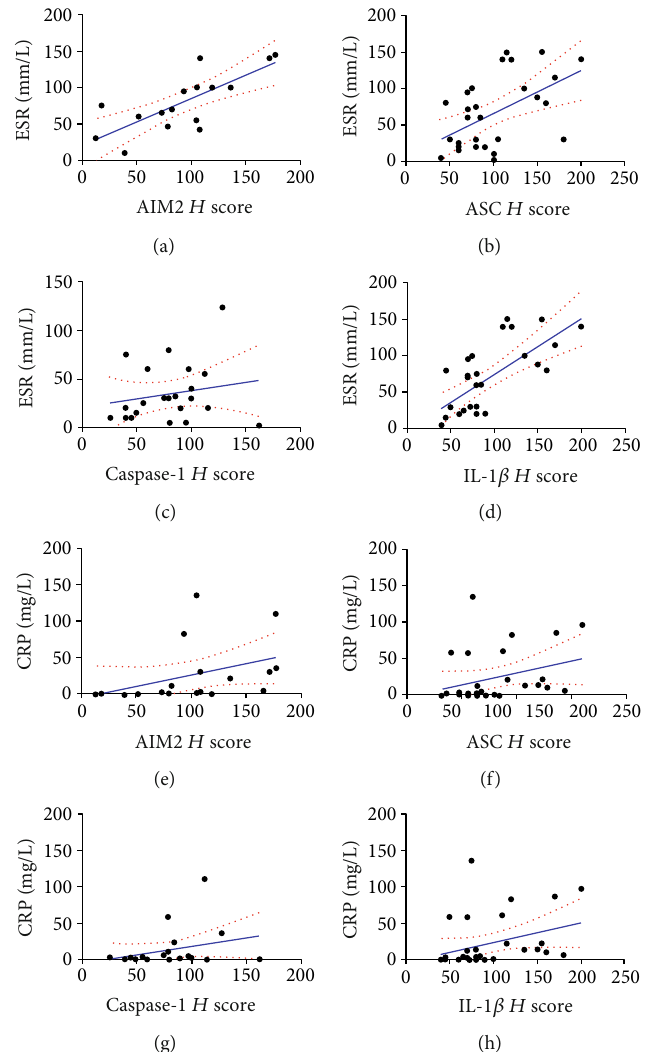
Figure 3: H scores of AIM2, ASC, and IL-1 β were positively correlated with ESR and CRP. AIM2 demonstrated a positive correlation with ESR ( r = 0 : 74 , p = 0 : 001 , 95% CI: 0.38-0.9) and CRP ( r = 0 : 65 , p = 0 : 003 , 95% CI: 0.25-0.86) (a, e). The positive correlations between ASC and ESR ( r = 0 : 5 , p = 0 : 005 , 95% CI: 0.16-0.74) as well as CRP ( r = 0 : 42 , p = 0 : 02 , 95% CI: 0.05-0.69) were detected (b, f). The positive correlations between IL-1 β and ESR ( r = 0 : 62 , p = 0 : 0004 , 95% CI: 0.31-0.81) and CRP ( r = 0 : 41 , p = 0 : 02 , 95% CI: 0.05-0.67) were detected. The correlations between CASPSE-1 and ESR as well as CRP were not statistically signi fi cant ( p > 0 : 05 ) (c,